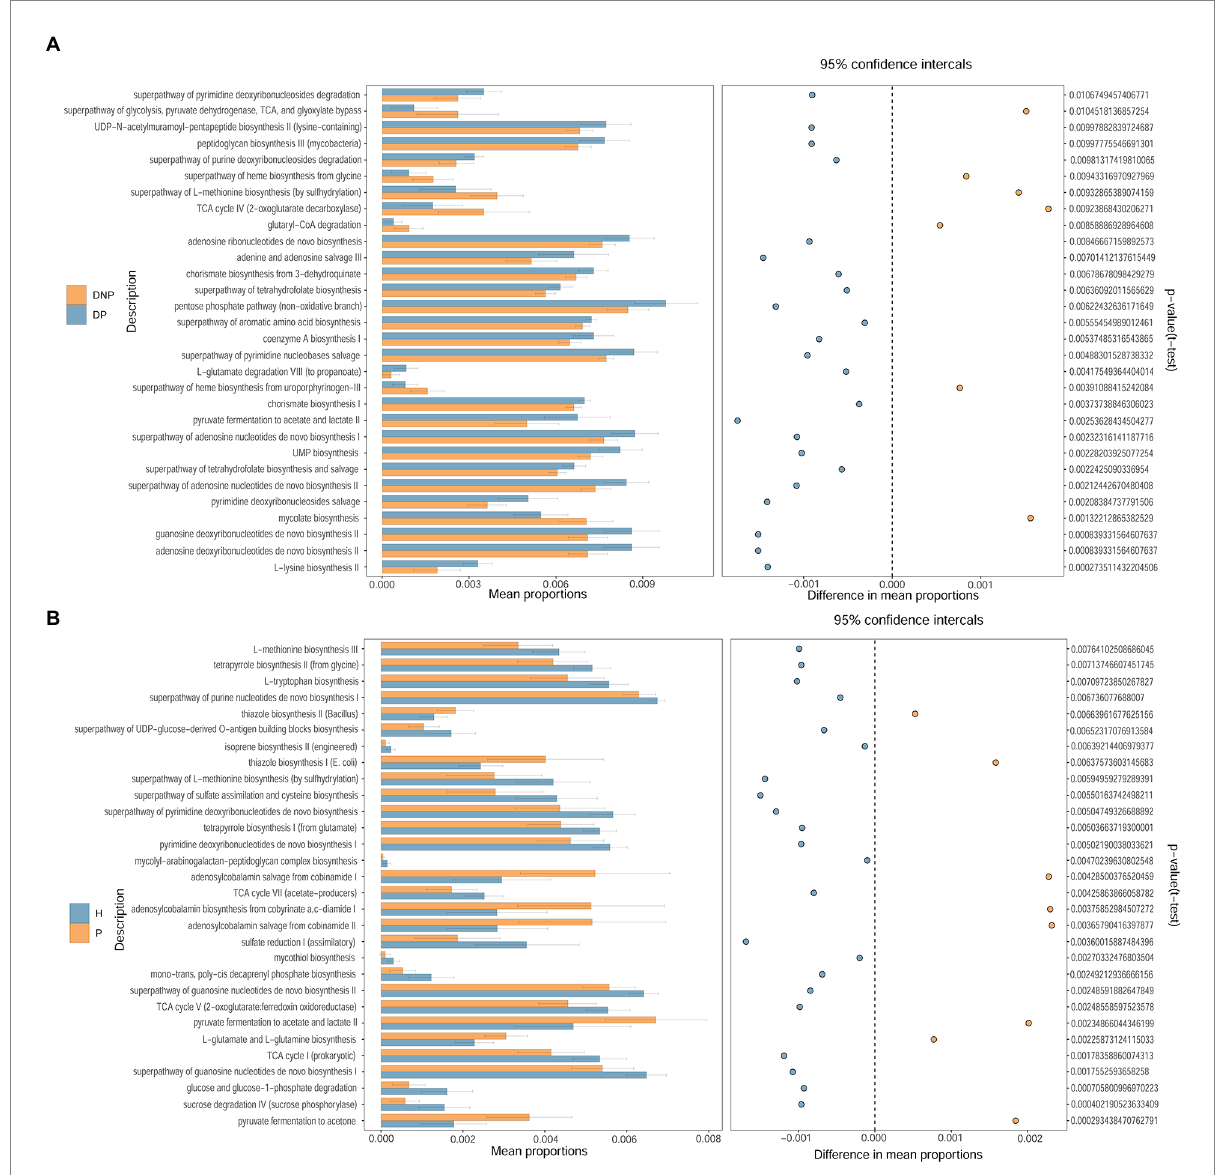
FIGURE 6 Different pathways between DP and DNP groups, as well as between P and H groups. Comparison of the KEGG Pathway of different bacterial groups and screening out pathways with significant differences between groups. The histogram on the left represents the abundance of metabolic pathways as a percentage of all metabolic pathways in the two sets of samples, while the histogram on the right is the corrected p -value. (A, B) Comparison of the KEGG Pathway of different bacterial groups and screening out pathways with significant differences between (A) DP and DNP; or (B) P and